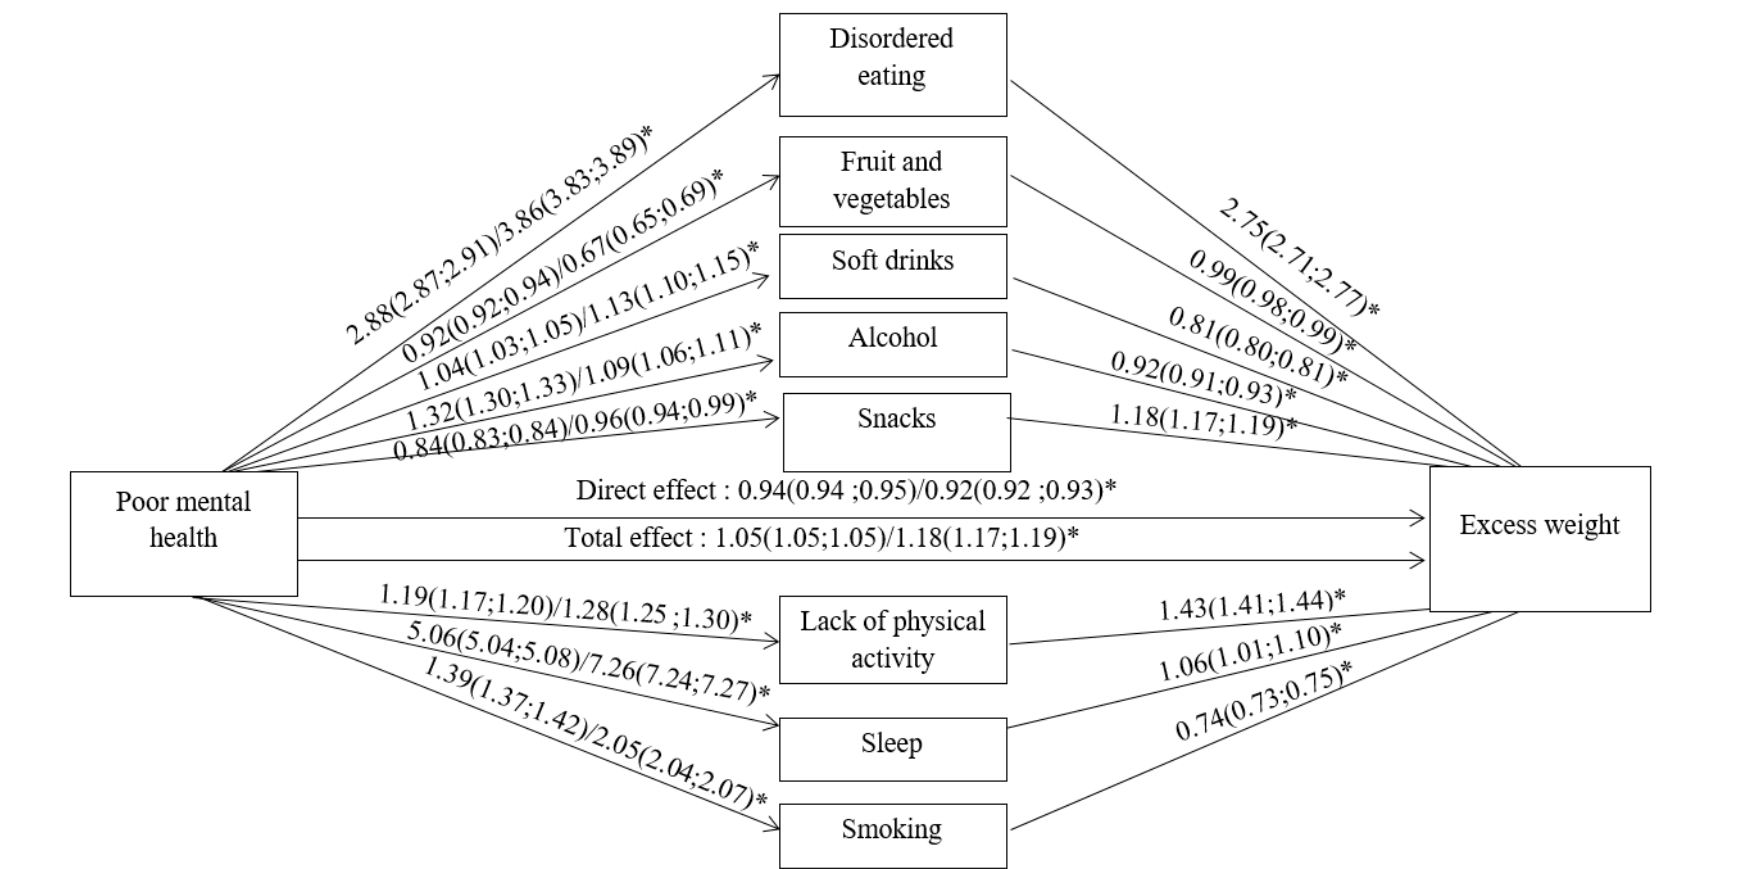
Figure 1. Logistic regression for associations between mental health, lifestyle, and excess weight. Odds ratios and 95% confidence intervals are shown as effect size: the first number is for stress, and the second is for anxiety and/or depression as mental health parameter. The total effect represents the association between mental health and excess weight without adjustment for lifestyle while the direct effect shows the association after adjustment for all lifestyle parameters. Analyses were adjusted for age, gender, income, education, and physical health, and weighted following the study design. * p < 0.05 (all were p < 0.01).